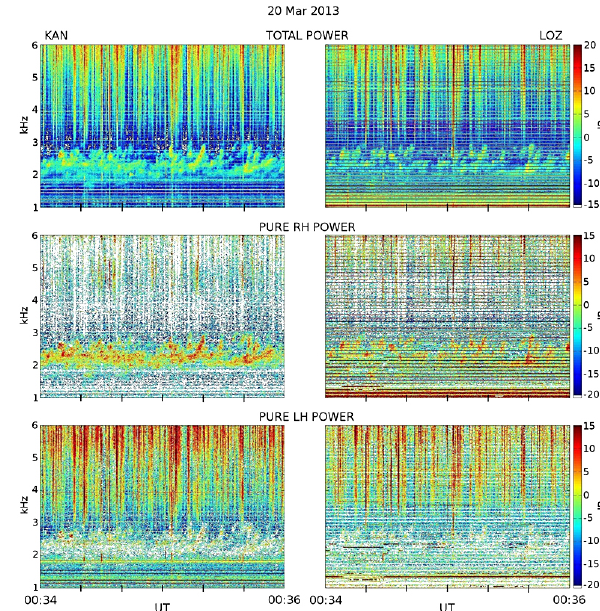
Figure 2. An example of simultaneous dynamic spectra of a VLF chorus observed at KAN and LOZ at 00:34–00:35UT on 20 March